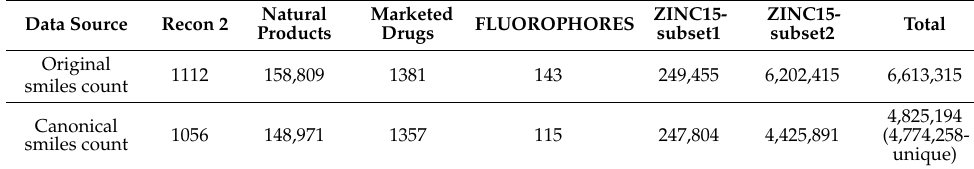
Table 1. Summary of